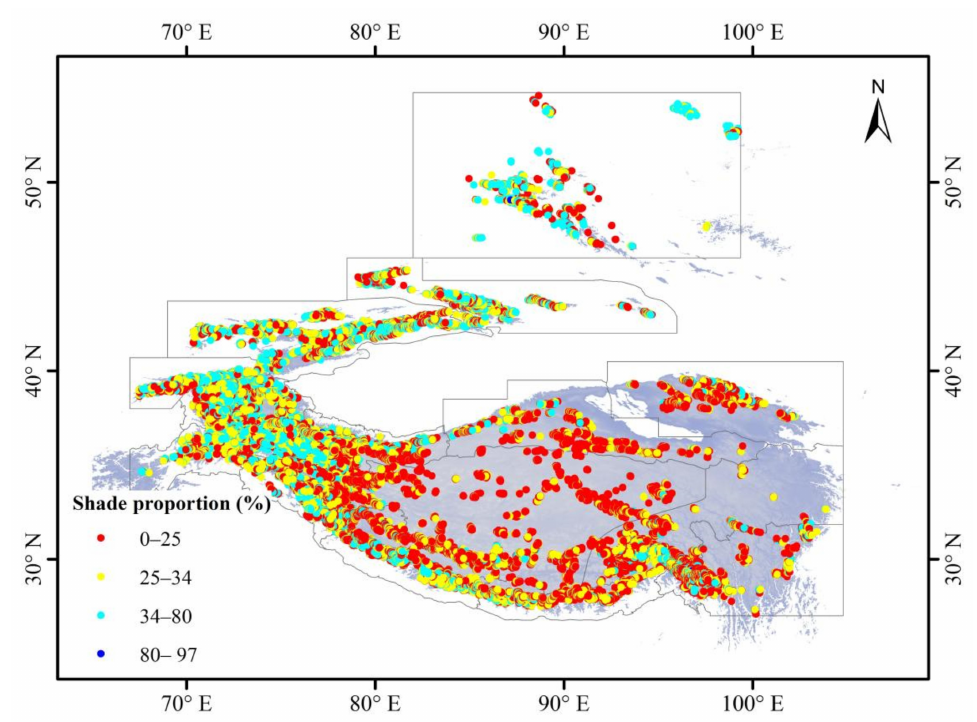
Figure 9. Shading area ratio for each glacier within